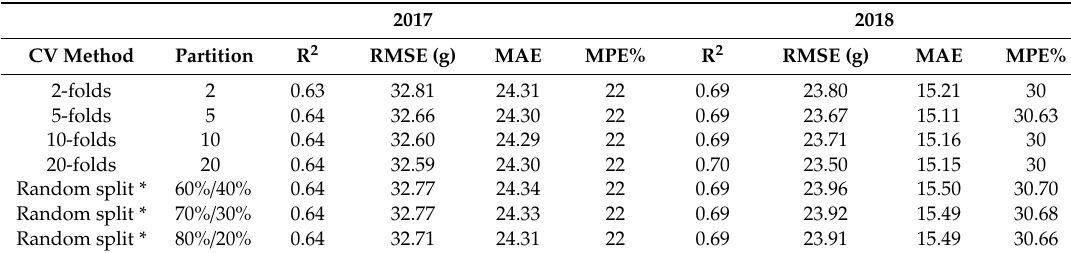
Table 3. Summary of cross-validation results for predicted fresh herbage yield (g / p). CV method: cross-validation method; R 2 : coe ffi cient of determination; RMSE: root mean square error; MAE: mean absolute error; MPE: mean percentage error.